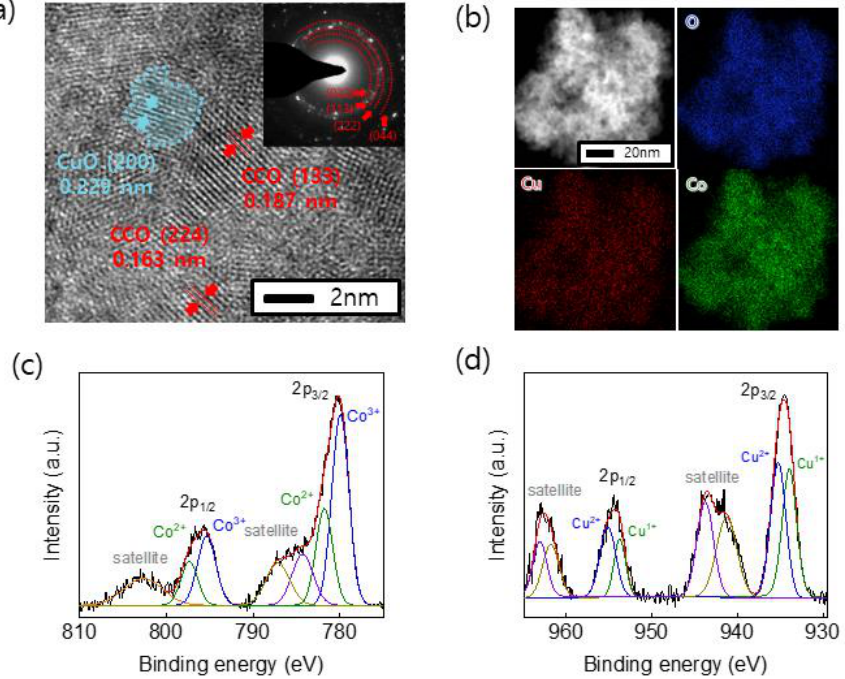
Figure 5. ( a ) High-resolution TEM image (blue, CuO d (200) = 0.229 nm; red, CCO d (133) = 0.187 nm and d (224) = 0.163 nm), ( b ) EDS elemental maps of (clockwise) O, Co, and Cu, and ( c ) Co 2p and ( d ) Cu 2p XPS core level spectrum of CCO-250 °C.